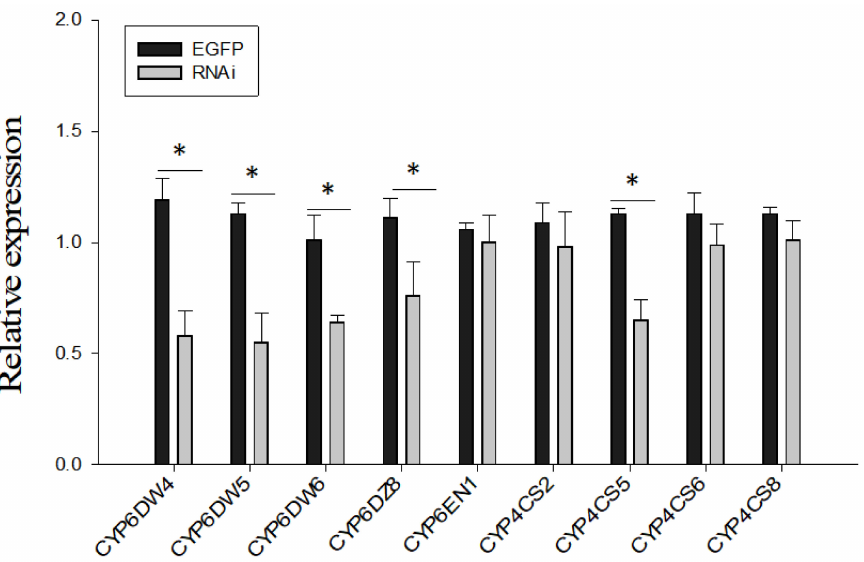
Figure 4. The mRNA level of different P450 in laboratory Bemisia tabaci MED after feeding dsRNA. The mRNA levels of P450 were assessed by RT-qPCR after 48 h dsRNA treatment. Values are means ± SE of three biological replicates. The asterisk (*) indicates a significant difference ( p <